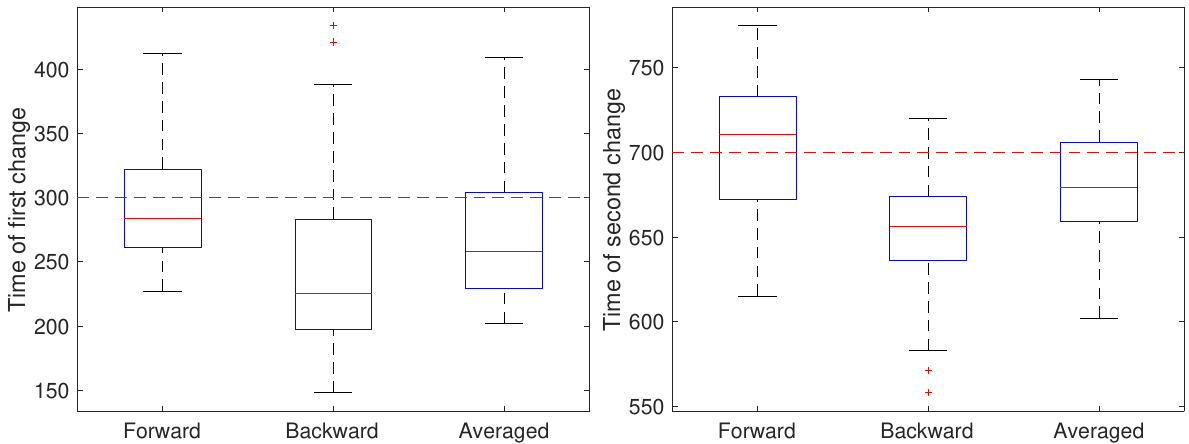
Figure 7. Detected time of change under a high noise setting based on using only the forward pass, only the backward pass, or averaging the two for the ( left ) first change (at k = 300) of the diffusion coefficient from 0.05 to 0.2 µ m 2 /s and the ( right ) second change (at k = 700 ) back to 0.05 µ m 2